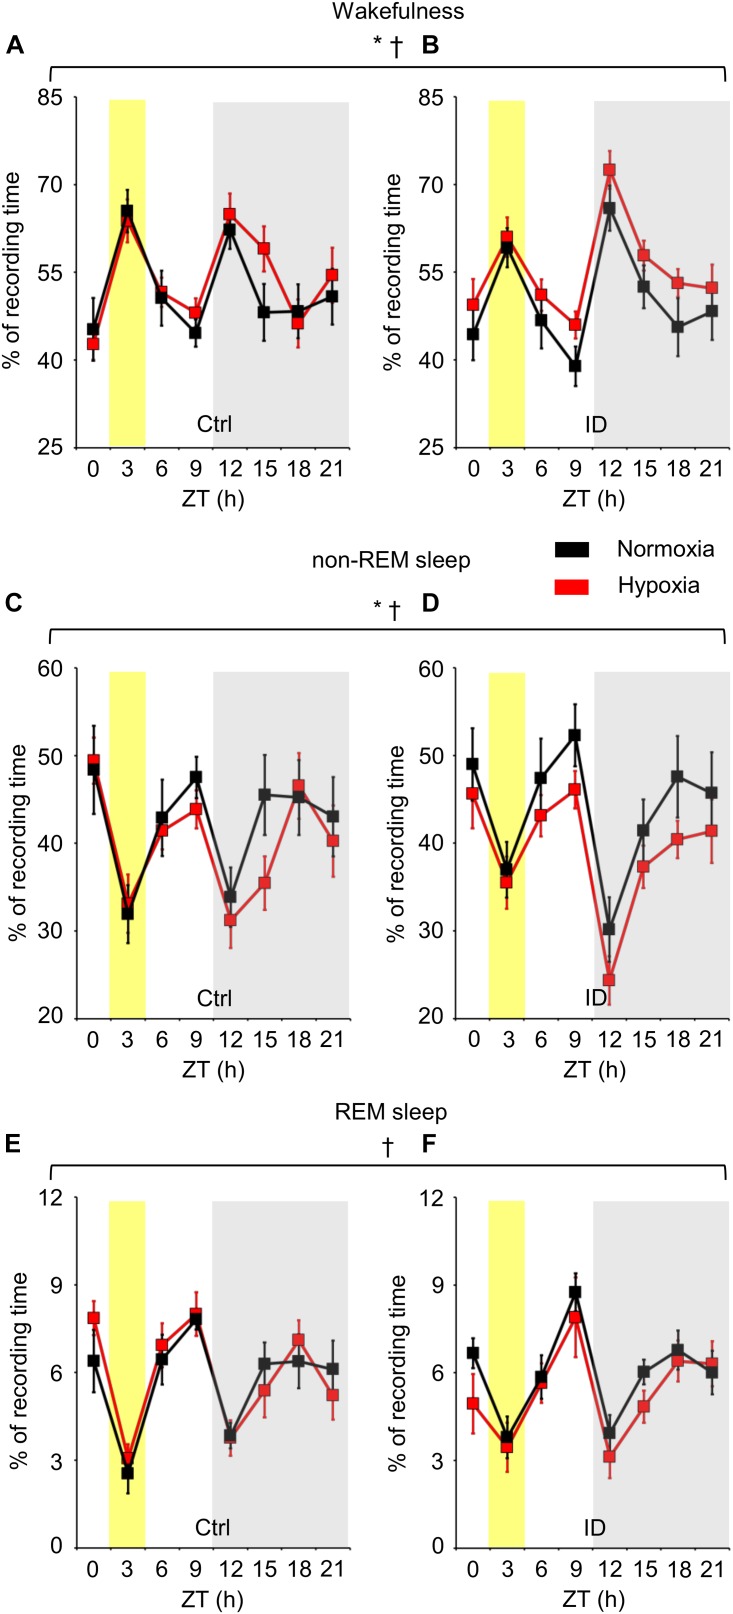
Percentages of recording time spent in wakefulness (A,B), non-rapid-eye-movement (non-REM) sleep (C,D), and rapid-eye-movement (REM) sleep (E,F), averaged every 3 h in mice fed control diet (Ctrl) or iron-deficient diet (ID) during normoxia (black) and hypoxia (red). Zeitgeber time (ZT) 0 is time at lights on. The gray shading indicates the period with lights off (dark period). The yellow shading indicates the 3-h bin including ZT 3, when mice were first transferred to the recording environment. Data are means ± SEM with n = 11 per group. ∗ and †, P < 0.05, main effects of hypoxia and ZT, respectively (ANOVA).